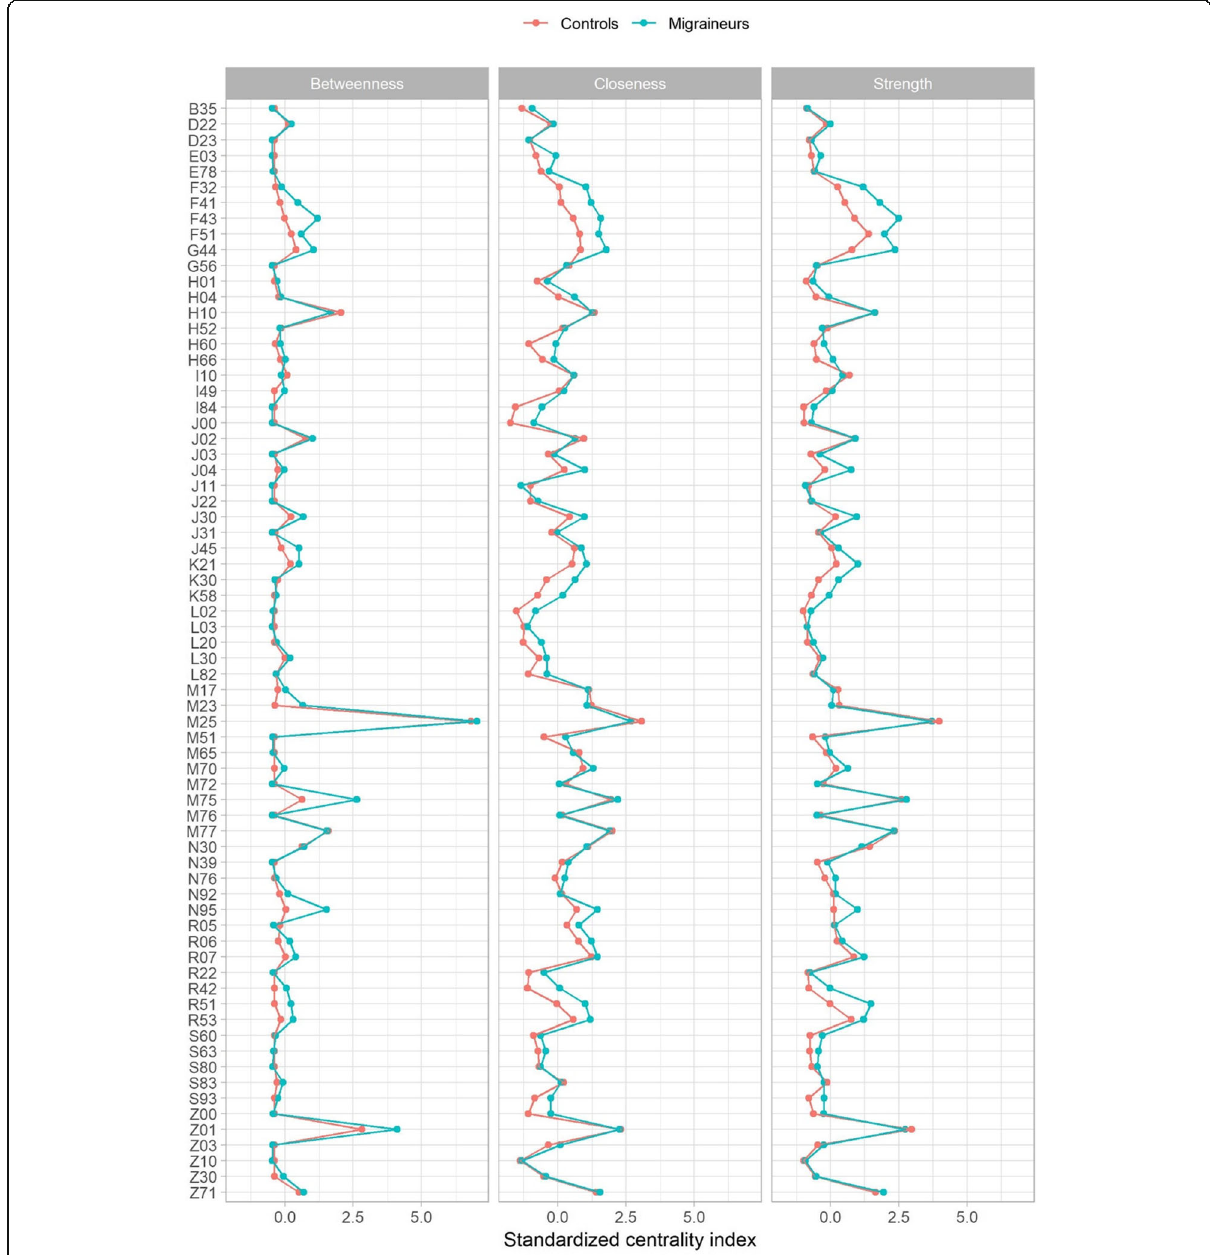
Fig. 4 Three centrality measures visualized for migraineurs and controls. These have been calculated from the PDNs in Fig. 2. Betweenness: how well a comorbidity connects other comorbidities; Closeness: how close the comorbidity is to other comorbidities in the PDN; Strength: the sum of phi correlations over all connected comorbidities. Note that instead of the raw centrality measure values, the standardized values (i.e. Z-scores) have been plotted. This enables the comparison of the values from the two PDNs. Generally, the centrality of the comorbidites in migraineurs follows the same pattern as in controls, however, there appears to be some differences in betweenness in F-codes, M75, N95 &